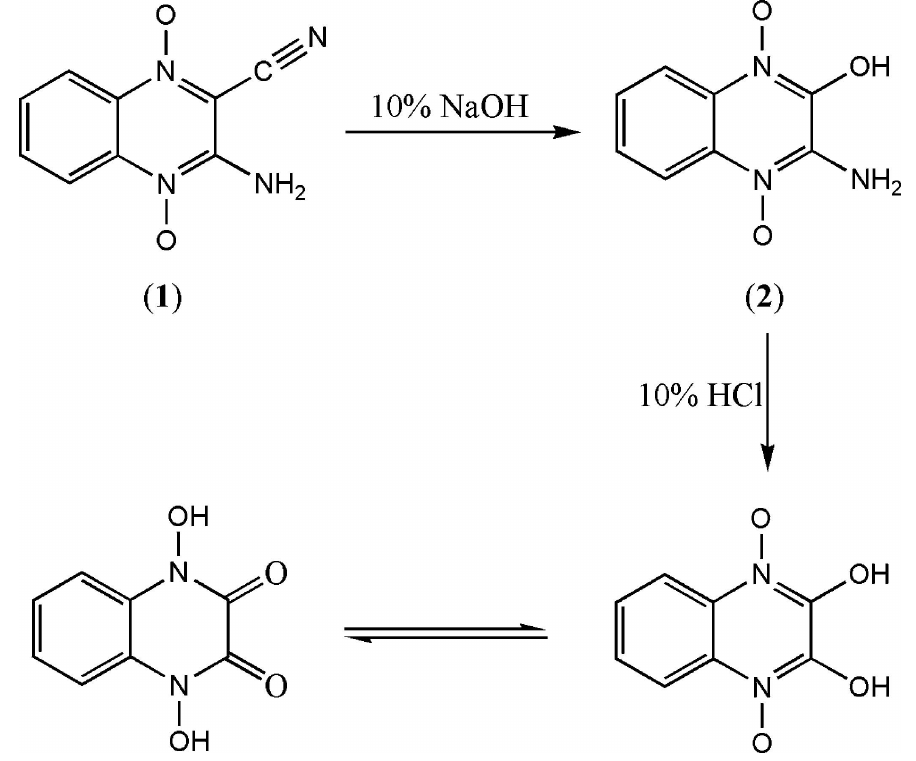
Schematic representation for the steps through which reaction